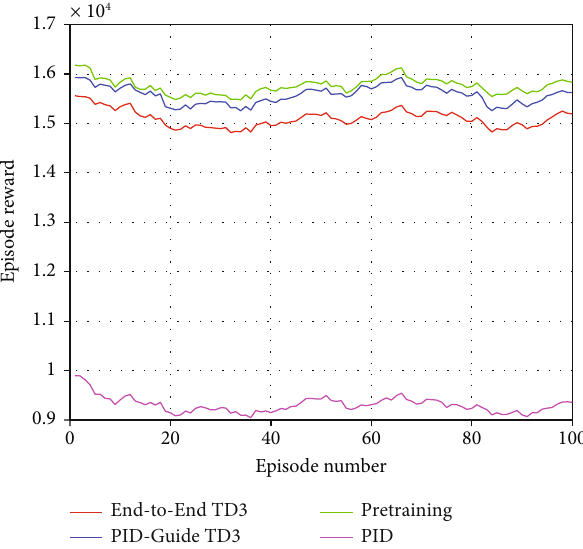
Figure 10: The testing process of di ff erent